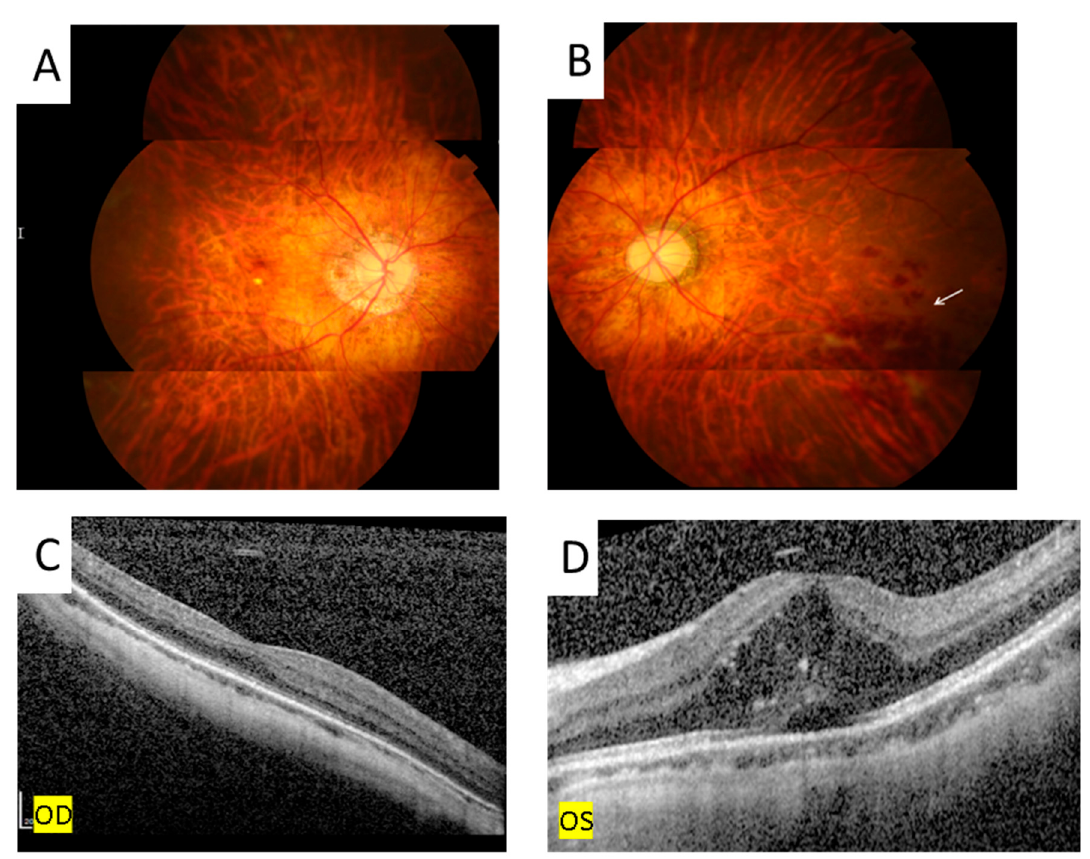
Figure 5. Fundus photography showed retinal hemorrhage (( B ), arrow) and OCT disclosed subretinal and intraretinal fluid with hyperreflective material over the left eye ( D ). There is no retinal hemorrhage ( A ) nor macular edema ( C ) over the right eye.